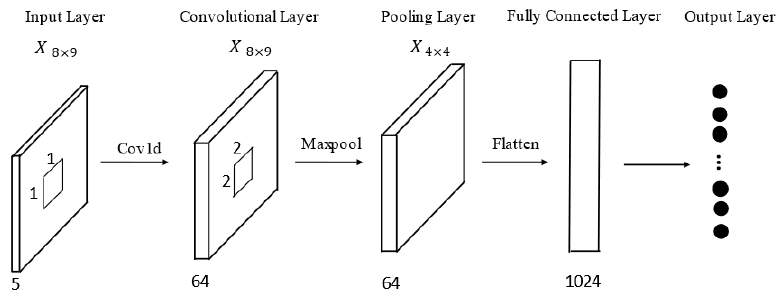
Figure 1. Typical CNN model.